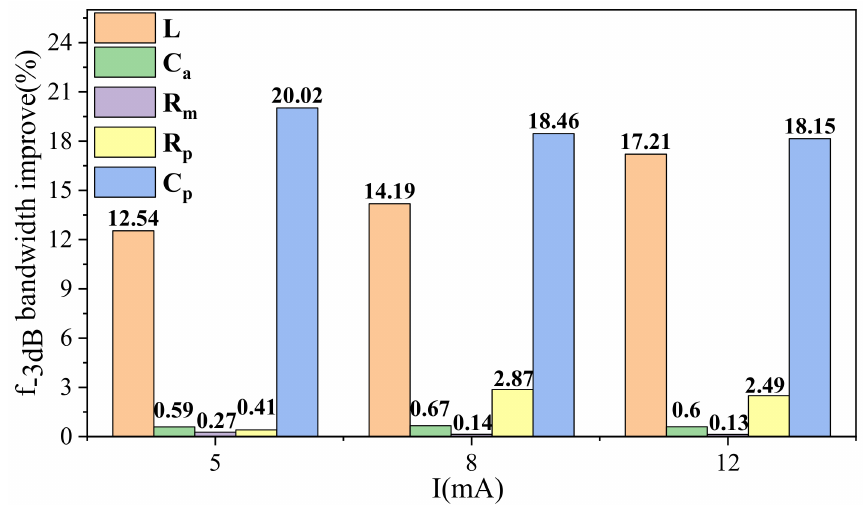
Figure 7. Improvement of − 3 dB bandwidth for a 30% decrease of single parasitic parameters, including L , C a , R m , R p , and C p at 5 mA, 8 mA, and 12 mA,